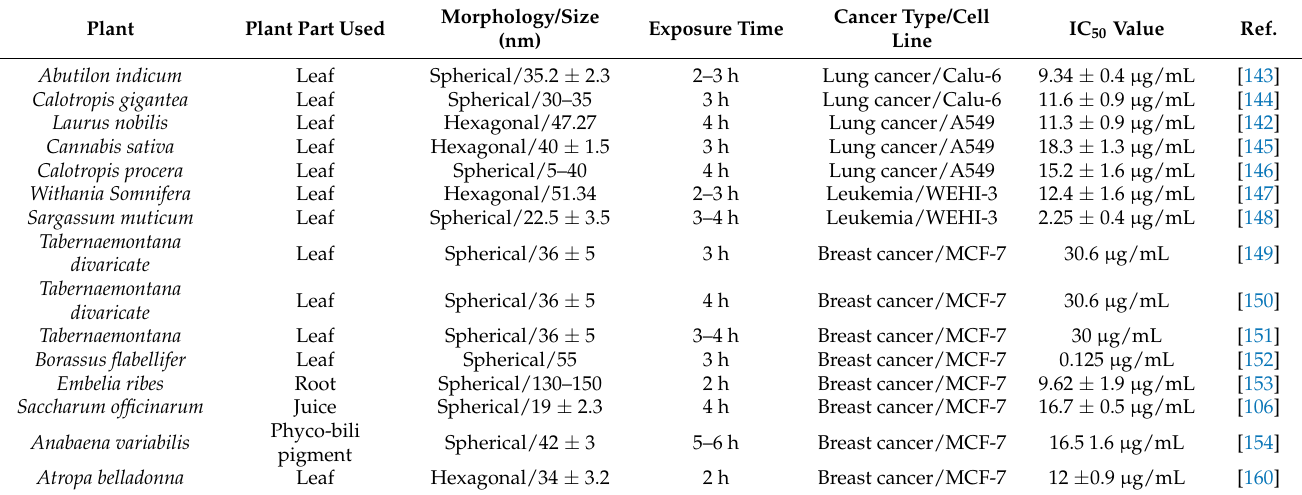
Table 3. List of studies exhibiting biosynthesized zinc NPs and their anticancer